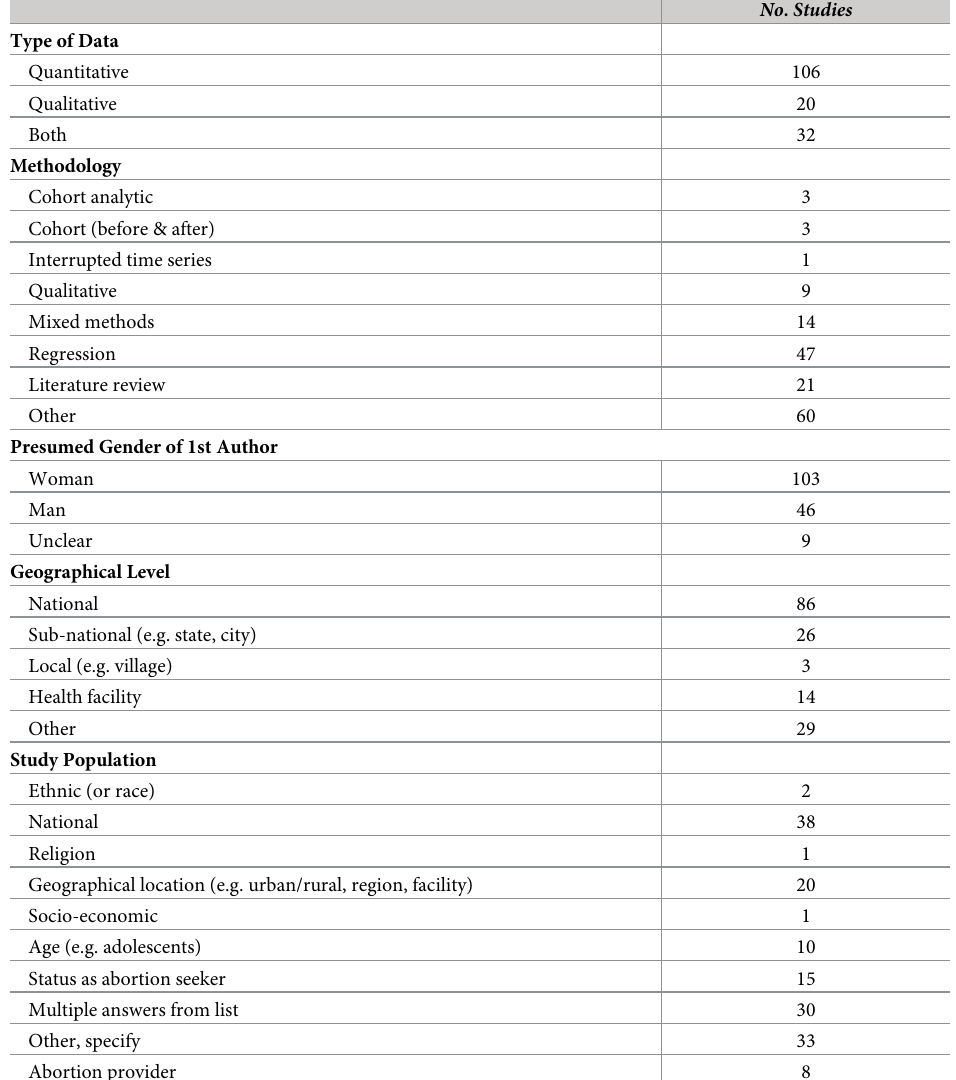
Table 4. Characteristics of included studies (n =